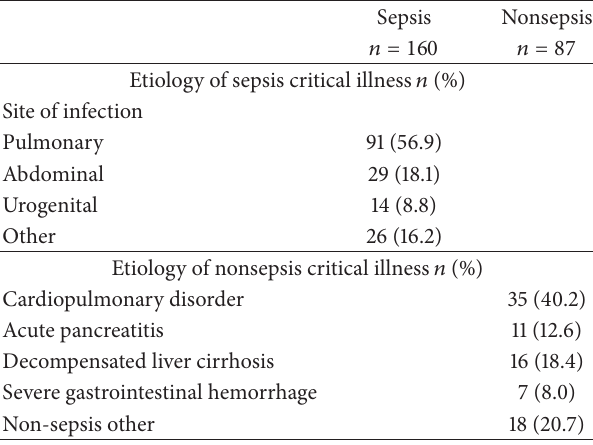
Table 2: Disease etiology of the study population.